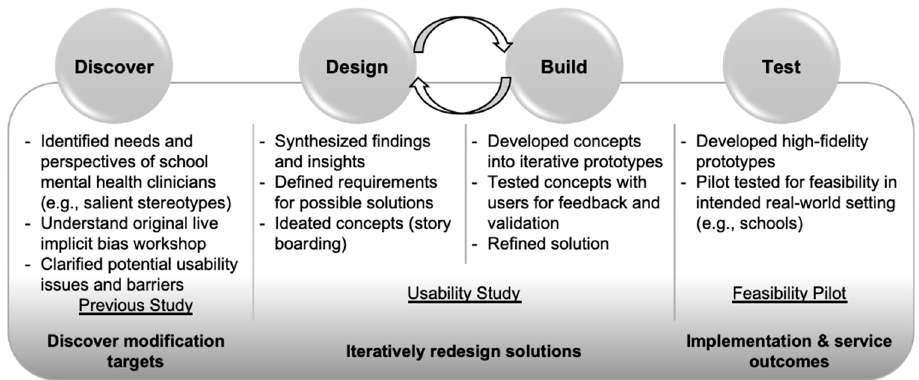
Figure 1. Discover, Design, Build, and Test Development Process Adapted from Lyon et al., 2019